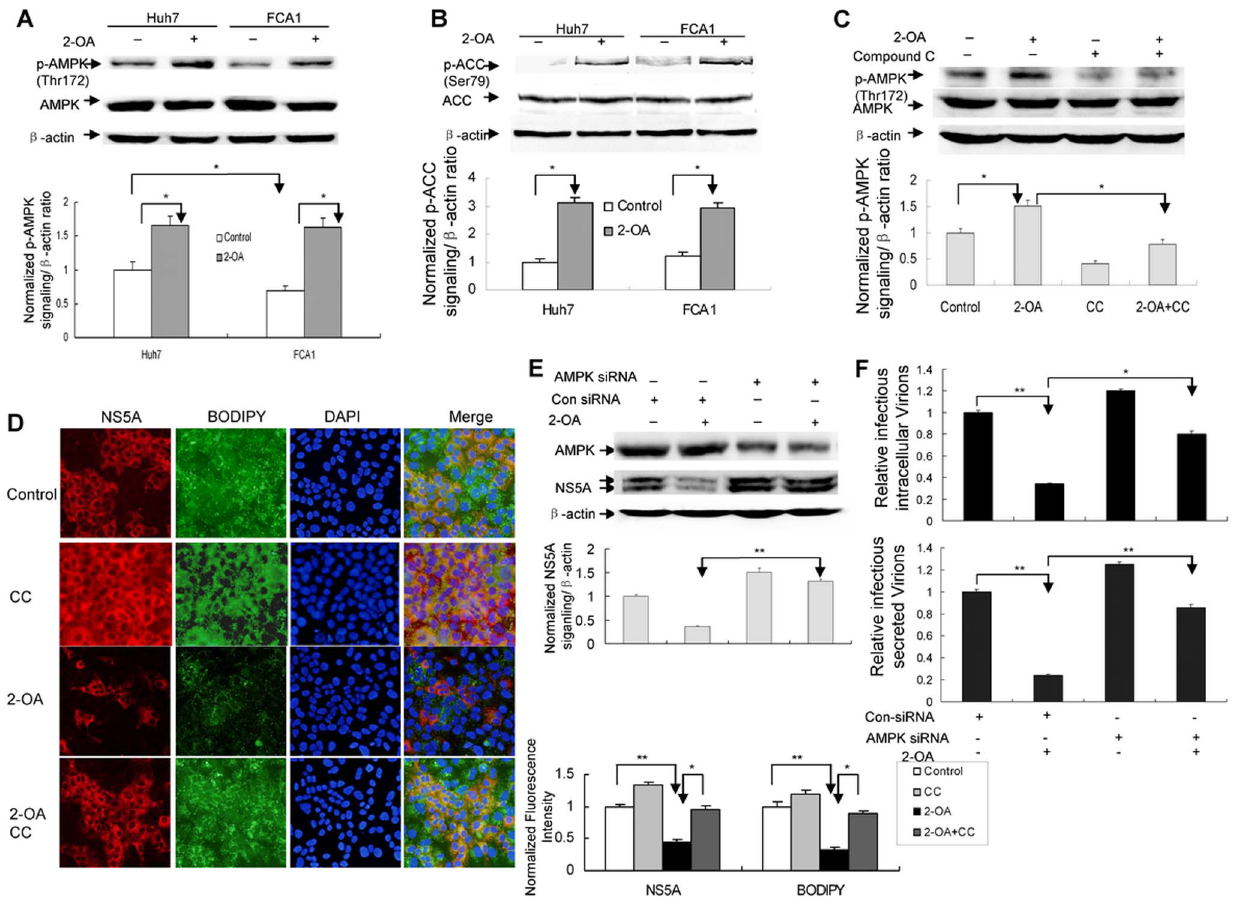
Figure 4. 2-OA antiviral effect is associated with AMPK activation. ( A ) / ( B ) 2-OA activates AMPK ( A ) and phosphorylates ACC ( B ) in replicon cells. Huh7 and FCA1 cells were treated with 100 m M 2-OA for 10 minutes. pT172 of AMPK and pSer79 of ACC were detected by western blot respectively. Levels of phosphorylated AMPK or ACC were quantified by densitometry in comparison with b -actin (lower). ( C ) Compound C (CC) blocks activation of AMPK by 2-OA. FCA1 cells were treated by 100 m M 2-OA and 10 m M compound C for 10 minutes. pT172 of AMPK was detected by western blot and quantified by densitometry in comparison with b -actin (lower). ( D ) Compound C inhibits 2-OA antiviral activity. FCA1 cells were treated with 100 m M 2-OA and 2.5 m M compound C for 48 hours. Cells were stained for lipid content with BODIPY dye (green) after NS5A labeling by immunofluorescence (red). DAPI was used for nuclear counterstaining (blue). Identical settings were maintained for image capture (left). Representative confocal images are shown. NS5A and lipid levels were quantified by densitometry and normalized to control cells (right). ( E ) / ( F ) Knockdown of AMPK abolishes 2-OA antiviral activity ( E ) and abrogates the suppression of infectious virus production by 2-OA ( F ). AMPK siRNA was delivered into HCV-infected cells. The cells were treated by 100 m M 2-OA for 72 hours. ( E ) AMPK protein or NS5A was detected by western blot (upper). NS5A levels were quantified by densitometry in comparison with b -actin (lower). ( F ) The extracellular or intracellular virus was titred. The infectivity titers in the supernatant or cell lysates are were normalized to that of control cells from three independent